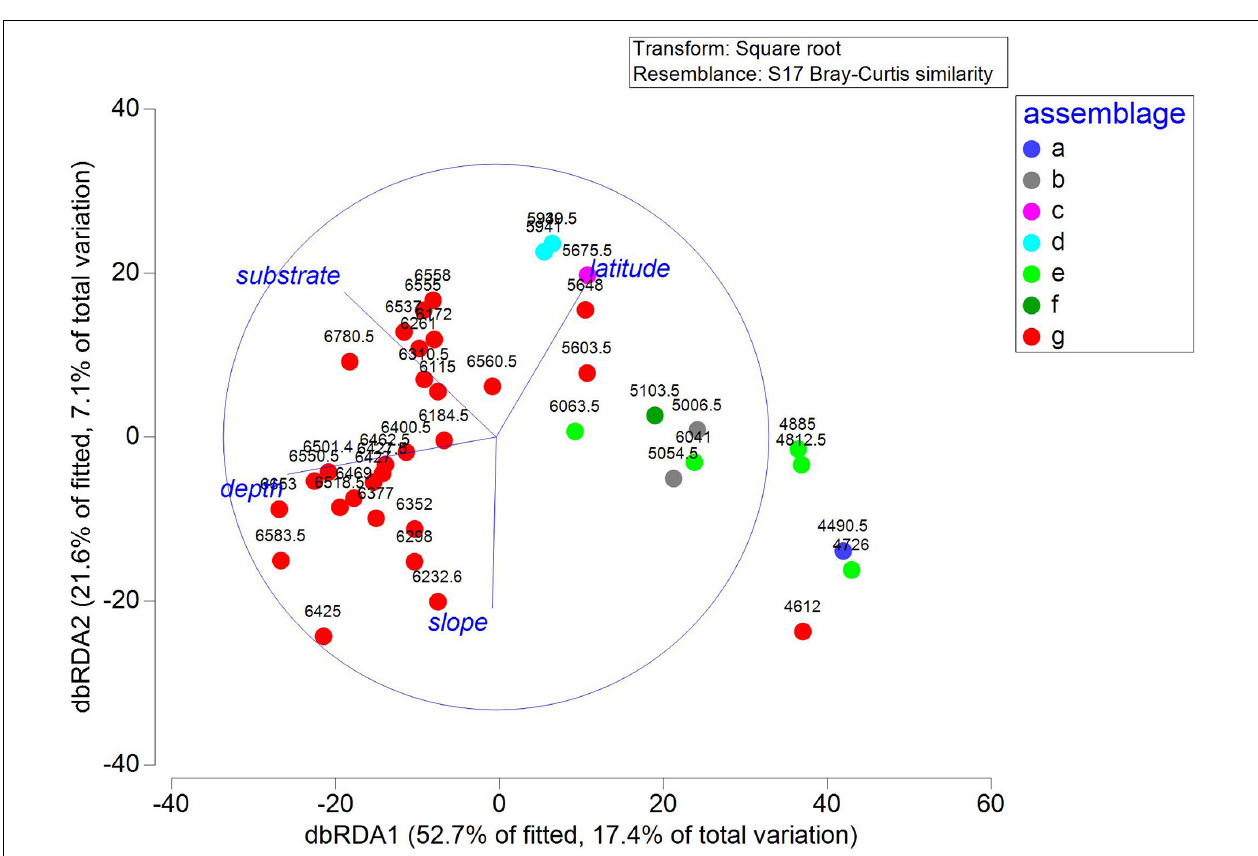
FIGURE 8 | Distance-based redundancy analysis (dbRDA) plots showing ordination of the DistLM model, sampling units are labeled by SIMPER assemblages and water depth, the lengths of overlaid vectors indicate the relative influence of the fitted predicting